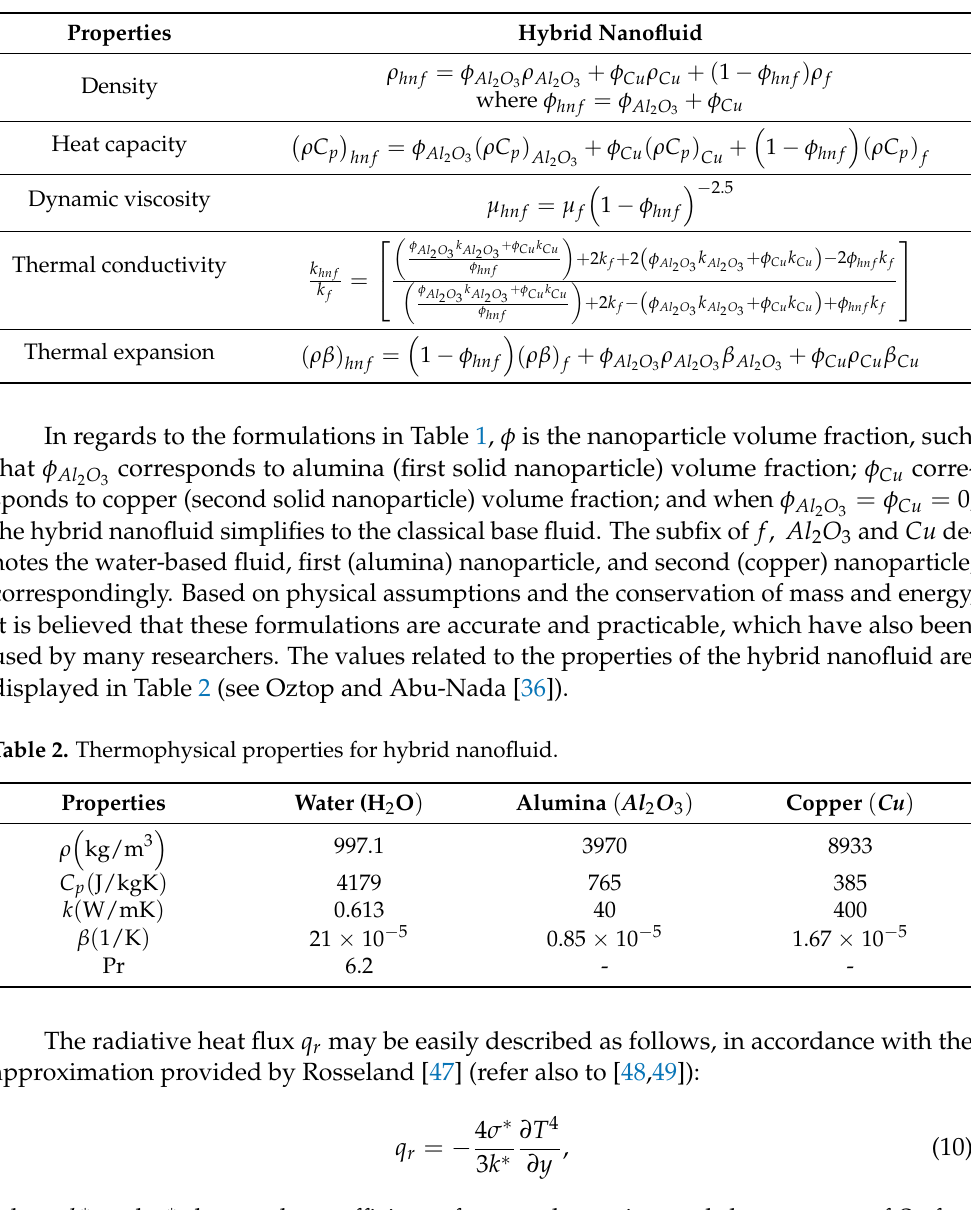
Table 1. Correlations for the thermophysical properties.